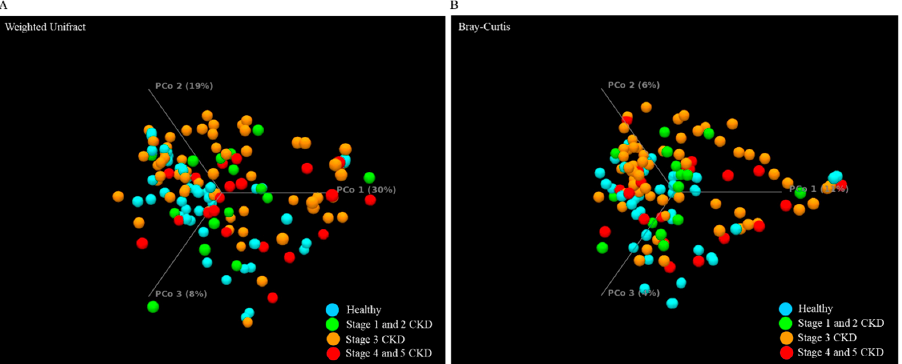
Figure 3. The dissimilarity between all groups with MinION sequencing results is illustrated